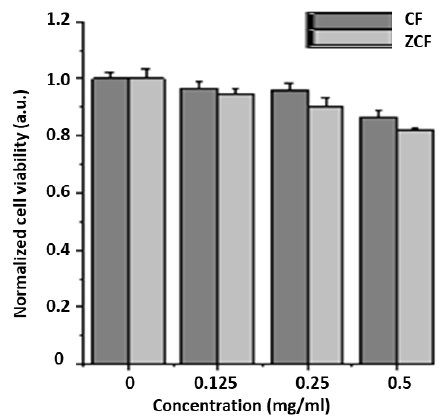
Figure 11. Cytocompatibility tests for CF-MNPs and ZCF-MNPs in in vitro culture with NIH-3T3.